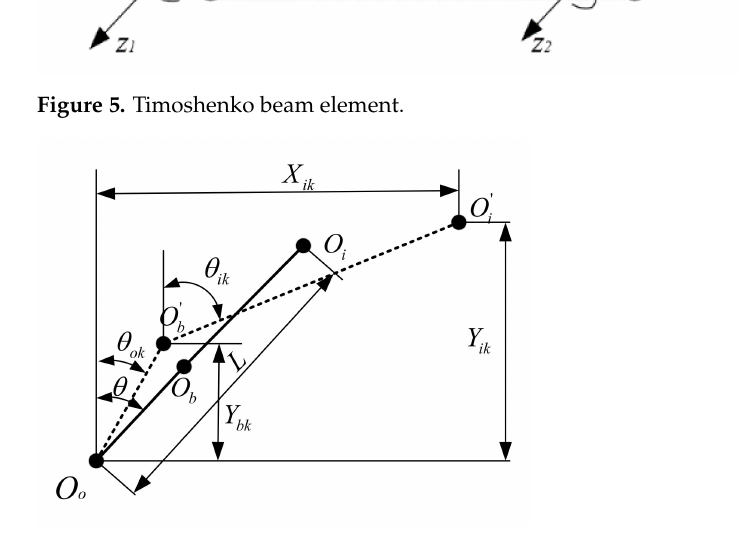
Figure 6. Positions relationship of ball center, inner and outer ring curvature